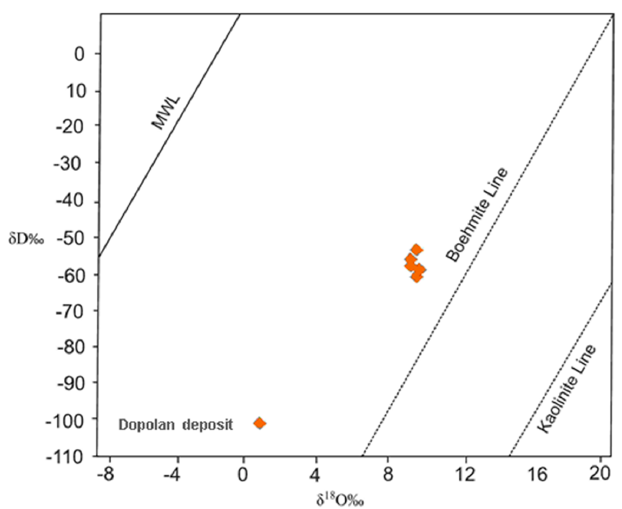
Figure 15. Isotope composition of bauxite horizons of the Dopolan deposit. Kaolinite line after [59]; boehmite line after [29]. MWL, Meteoric water line. SMOW, Standard mean ocean water.